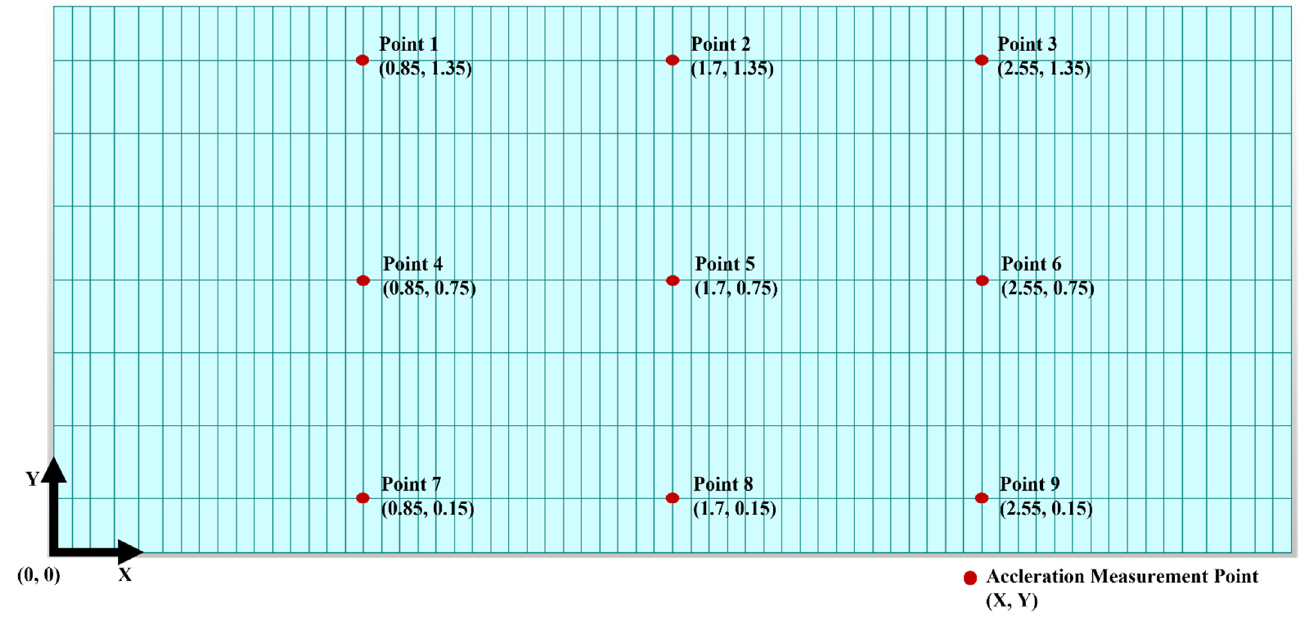
Figure 5. Acceleration measurement points on the bridge deck for rigid-frame-bridge modeling (Units: m).